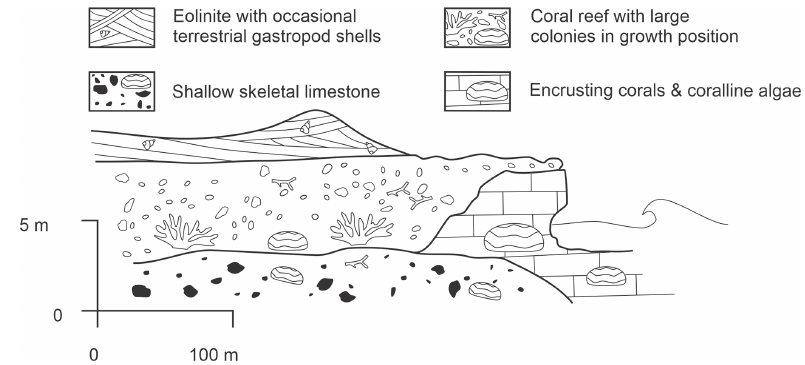
Figure 4. Raised reef and eolinites of southern Somalia (modified after Carbone and Accordi,